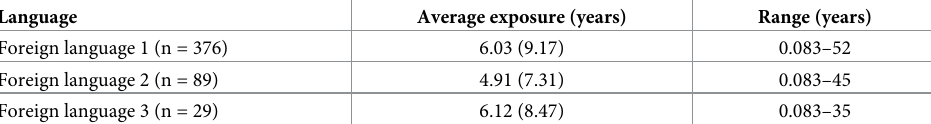
Table 2. Average exposure (and standard deviations) and range of exposure to foreign languages in the